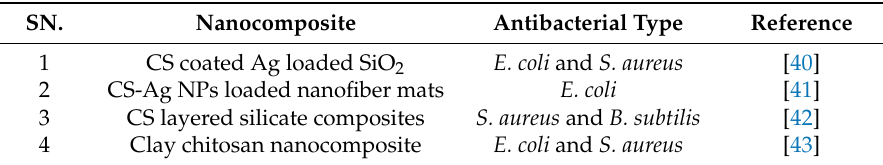
Table 3. Chitosan-nanocomposites and their respective antibacterial activity. SN.